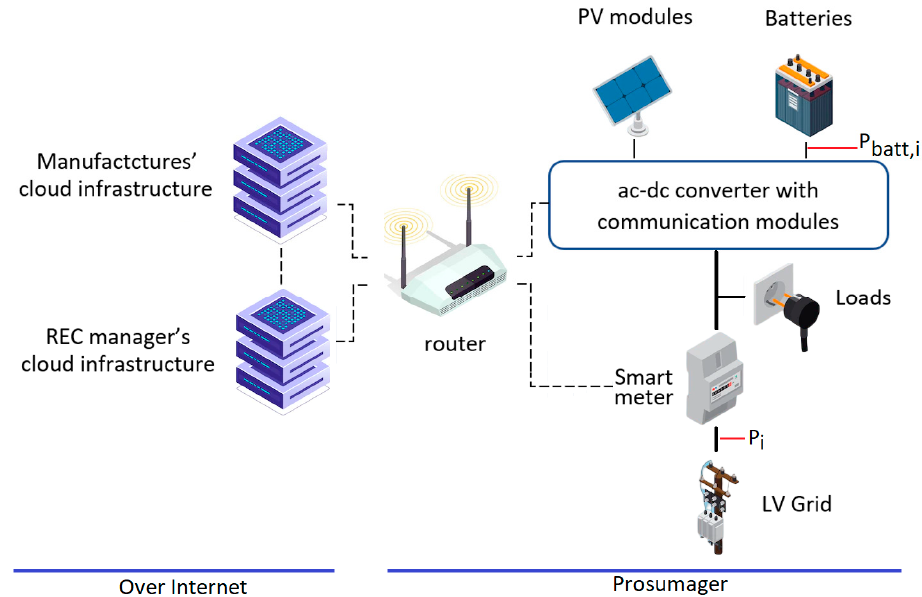
Figure 2. A grid-connected prosumer and the data flow from/to cloud infrastructures. The di ff erence between the reference and measured value returns the error 𝑒 =